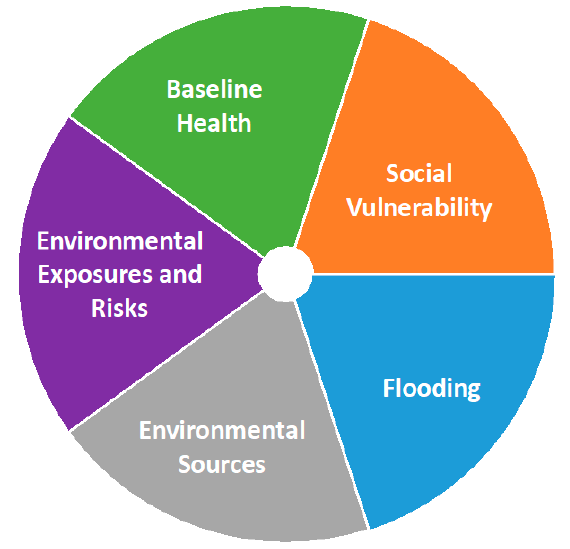
Figure 1. Domains of vulnerability of concern to partner communities in the Houston–Galveston–Brazoria (HGB) area (see Table 1 for details).